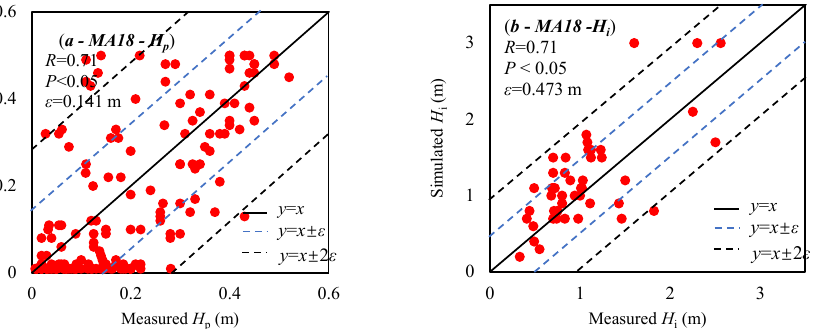
Figure 8. Panel ( a ) is the retrieval of H p and panel ( b ) is the retrieval of H i for the MA18 algorithm under overcast sky conditions using the pond color.